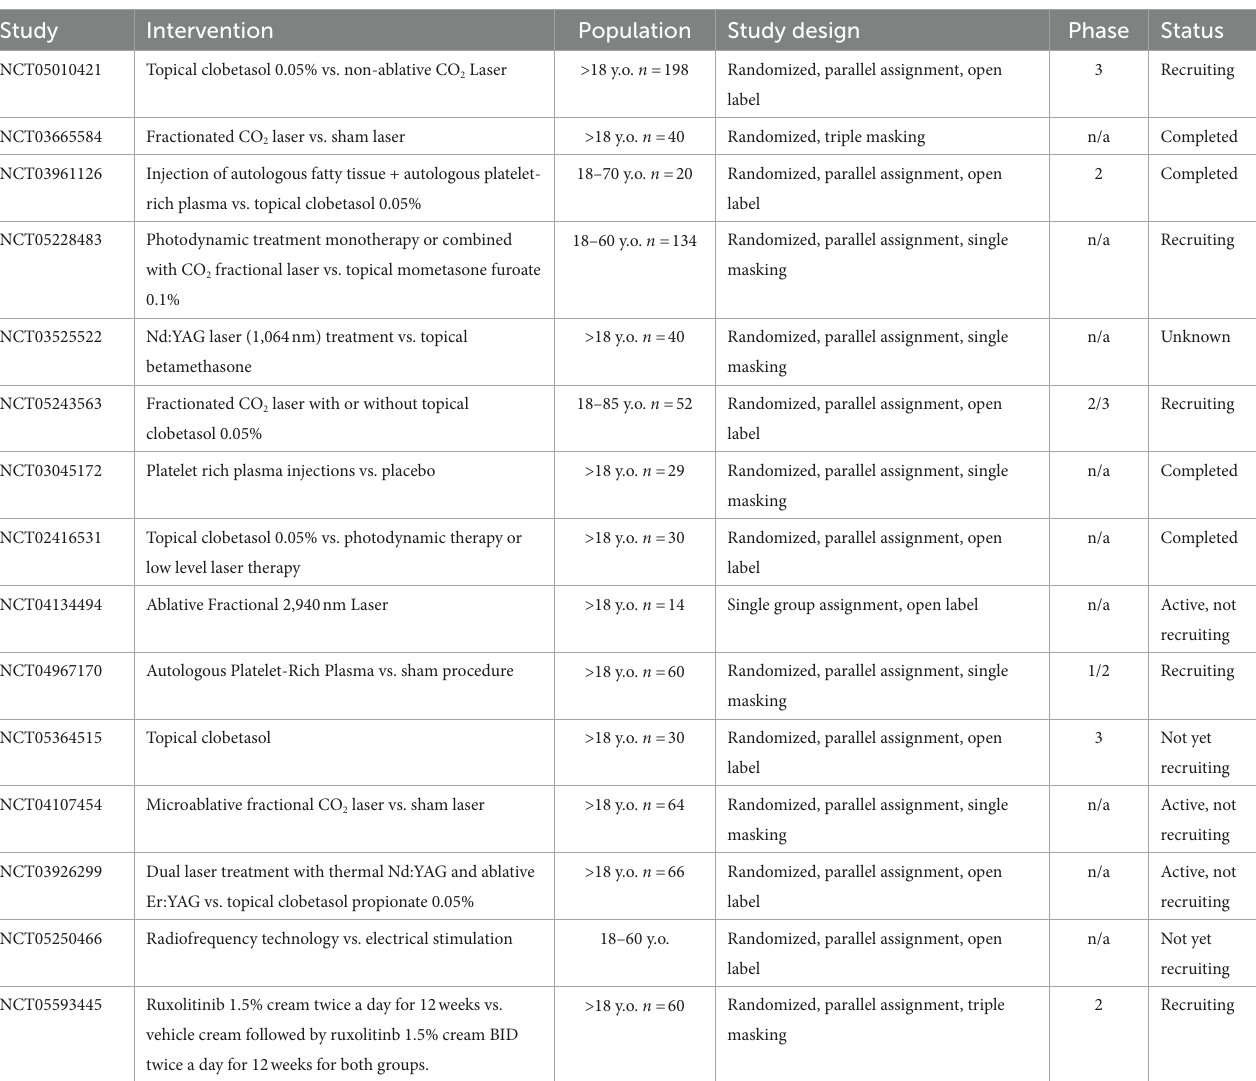
TABLE 7 Selected interventional clinical trials in female anogenital lichen sclerosus. Study Intervention Population Study design Phase NCT05010421